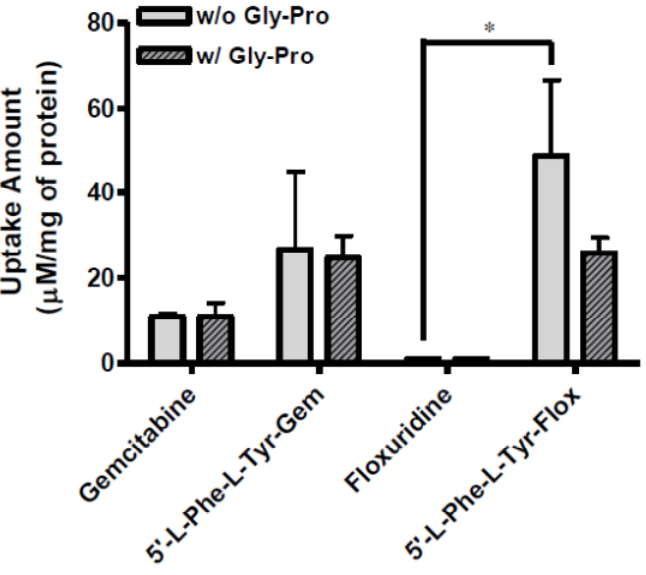
Table 3. Composition of floxuridine, floxuridine prodrug, gemcitabine and gemcitabine prodrug in Caco-2, Panc-1, and AsPC-1 cell uptake studies (mean ± SD, n = 3). Prodrug Compound Cells Metabolite * (%) Parent drug * (%) (%) Gemcitabine 5 95 - 5 ′ - L -Phenylalanyl- L -tyrosyl-gemcitabine 3 91 6 Caco-2 Floxuridine 100 0 - 5 ′ - L -Phenylalanyl- L -tyrosyl-floxuridine 8 47 45 Gemcitabine 80 20 - 5 ′ - L -Phenylalanyl- L -tyrosyl-gemcitabine 76 15 9 Panc-1 Floxuridine 0 0 - 5 ′ - L -Phenylalanyl- L -tyrosyl-floxuridine 0 2 98 Gemcitabine 10 90 - 5 ′ - L -Phenylalanyl- L -tyrosyl-gemcitabine 28 33 39 AsPC-1 Floxuridine 67 33 - 5 ′ - L -Phenylalanyl- L -tyrosyl-floxuridine 40 0 60